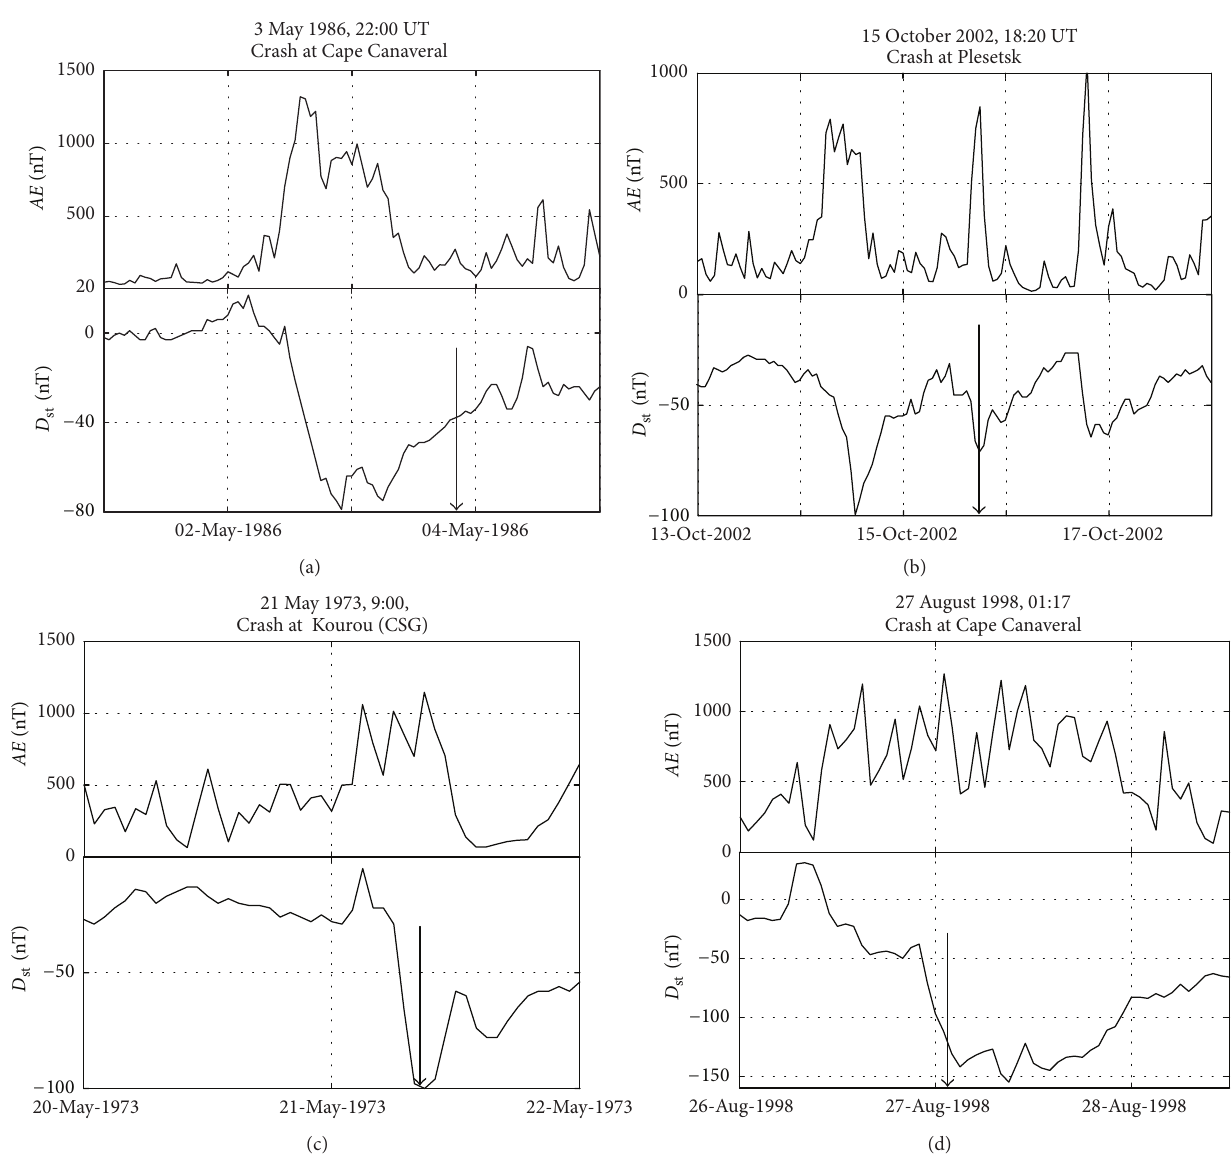
Figure 7: Examples of launch failures during magnetic storms: (a) rocket Delta at Cape Canaveral on May 02, 1986, (b) rocket Soyuz at Plesetsk on October 15, 2002, (c) rocket Diamant B at Kourou on May 21, 1973, and (d) rocket Delta at Cape Canaveral on August, 27, 1998.